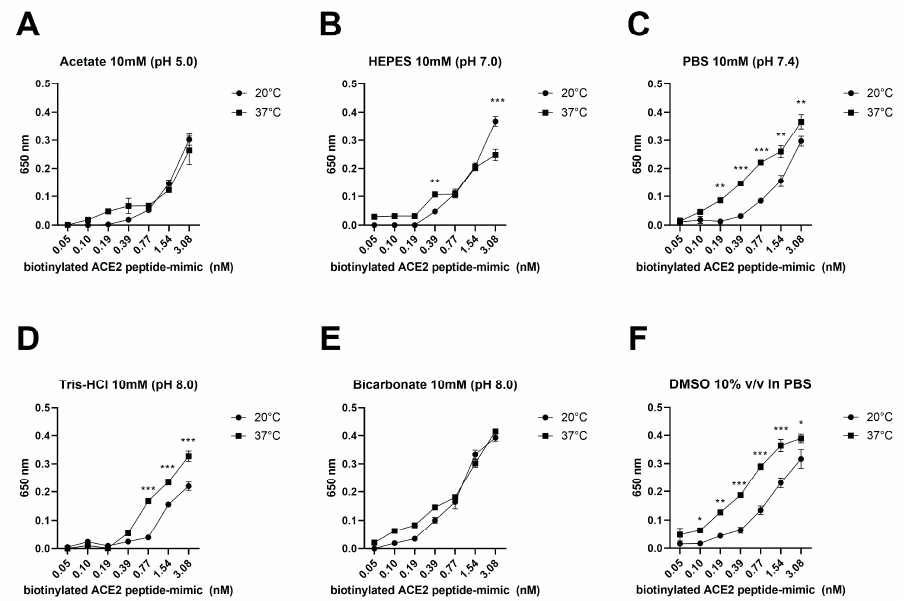
Figure 3. Synthetic ACE2 peptide mimic stability evaluation in different environmental conditions.